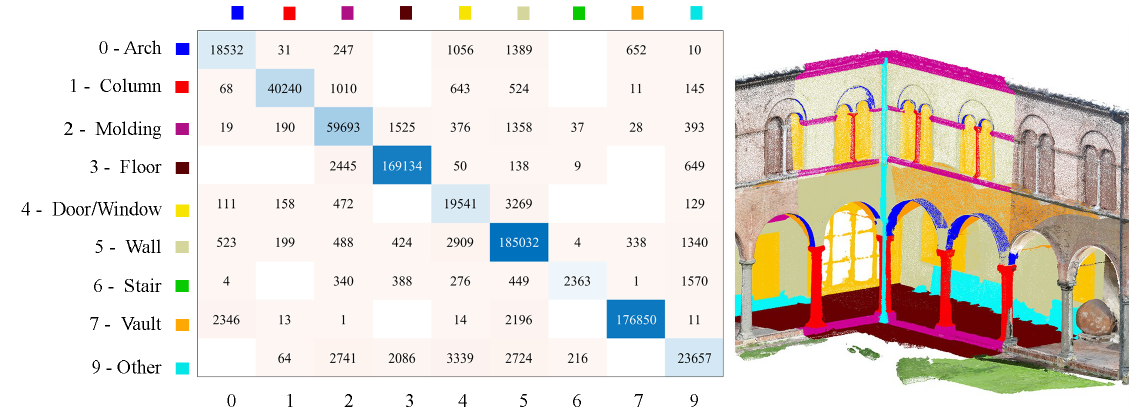
Table 1. Average performance measures for the three case studies.